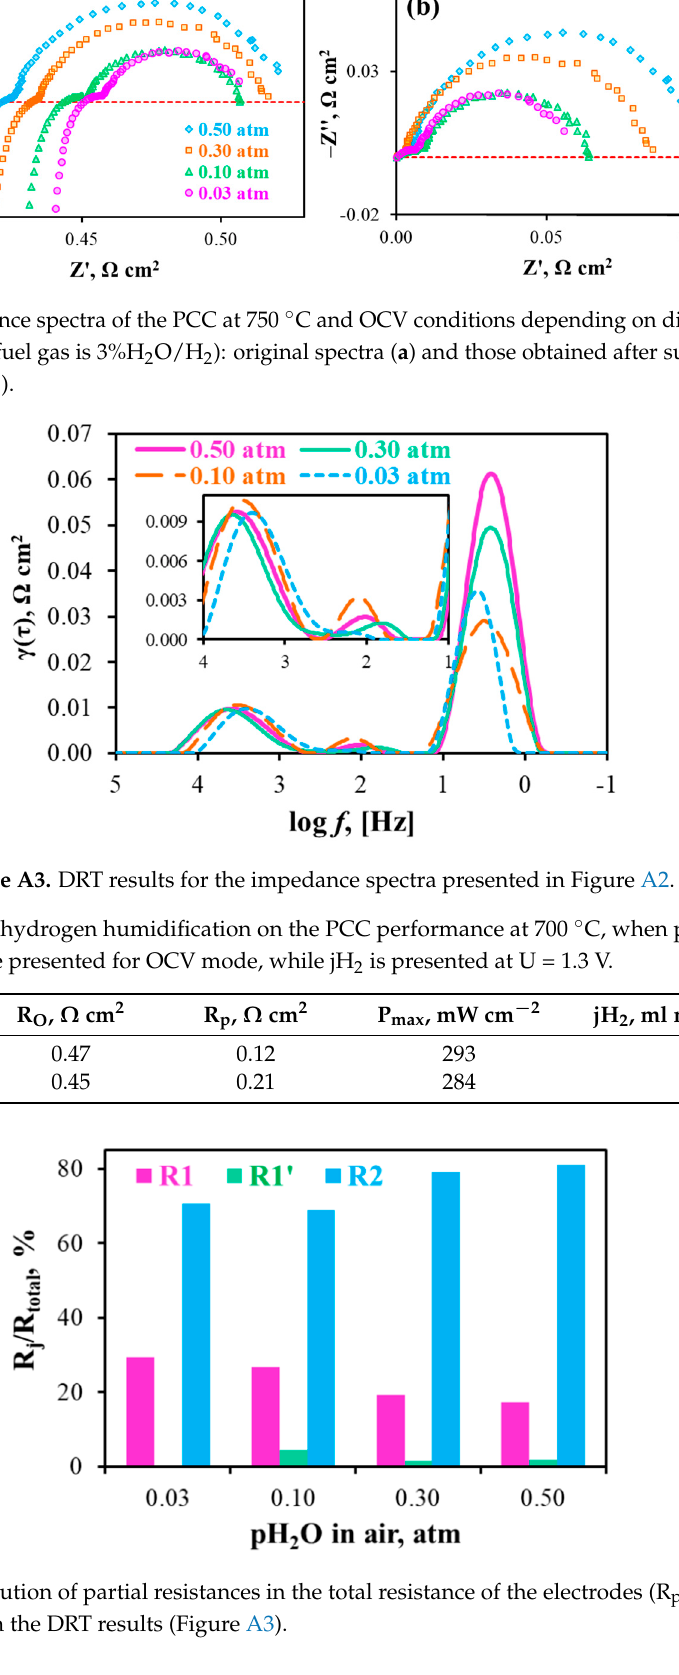
Figure A5. DRT results for the impedance spectra measured for the PCC at 750 °C under OCV conditions at different pH 2 O values in hydrogen atmosphere (p’’H 2 O in air is equal 0.5 atm). References 1.